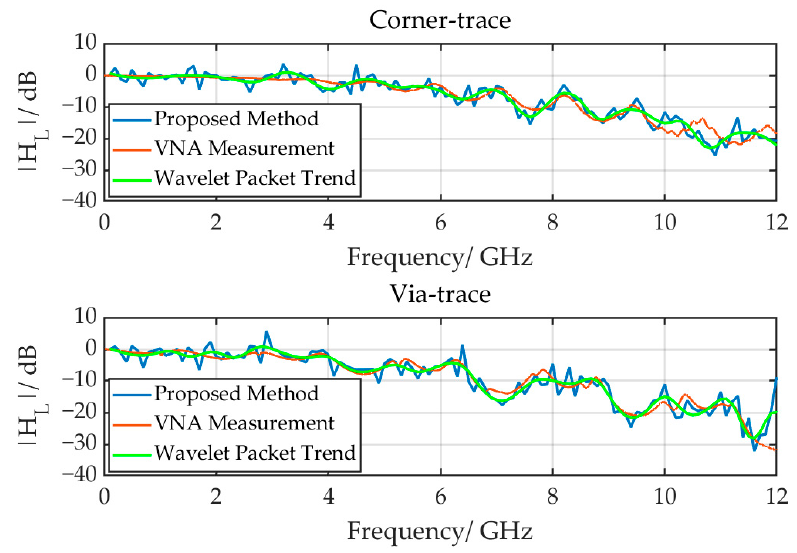
Figure 12. The extracted transmission characteristics of a corner trace and a via trace measured using proposed method and their trends compared with those obtained using a VNA.